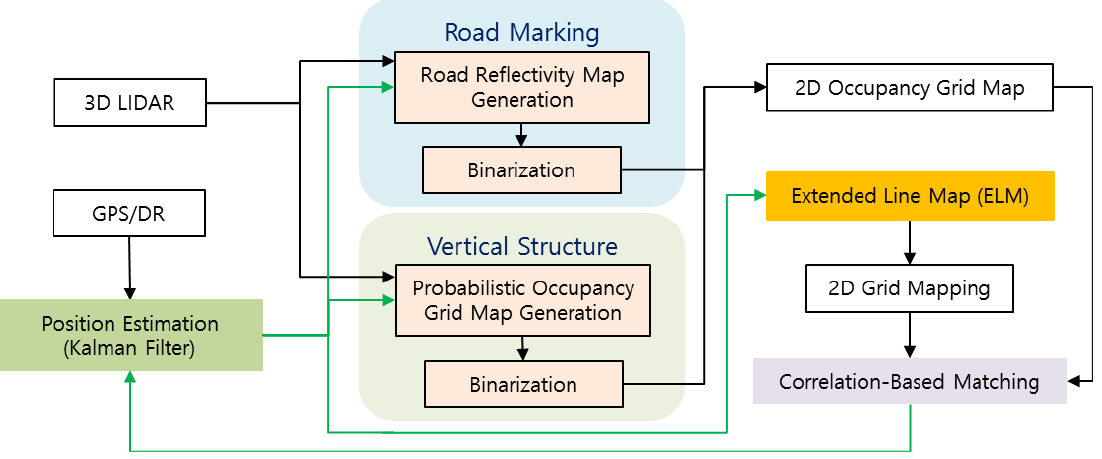
Figure 2. Localization process using ELM.